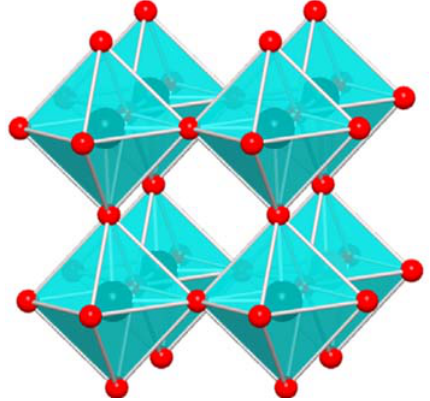
Figure 1. WO 3 cubic structure. Reproduced with permission [20]. Copyright 2019, Wiley.